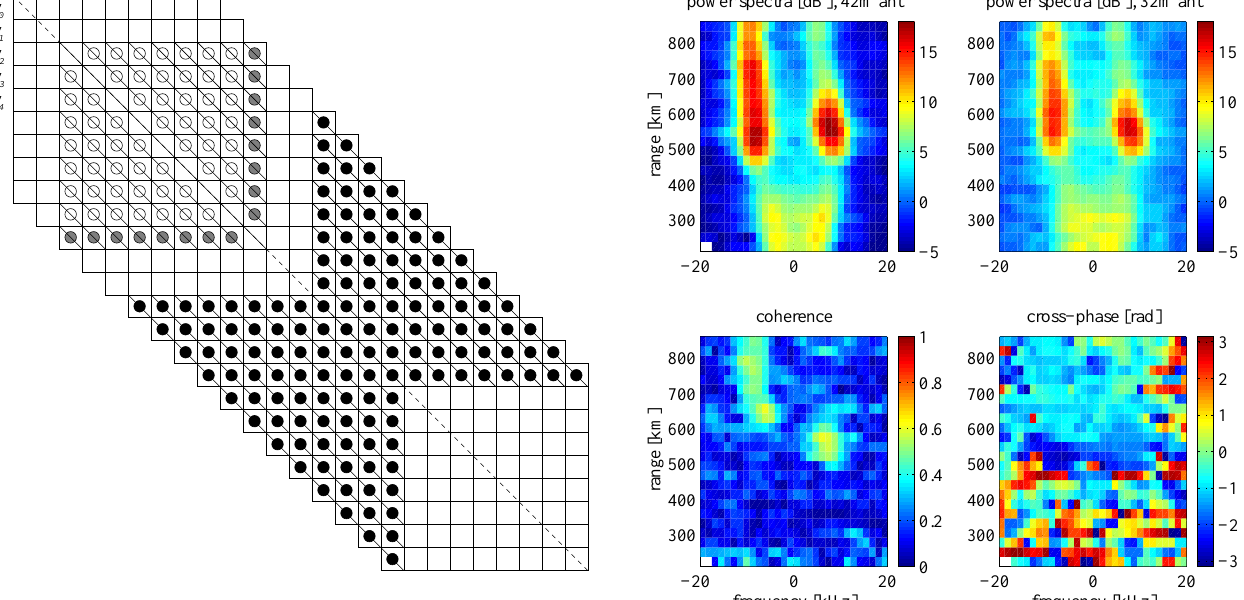
Fig. 12. A small cross-correlation lag profile matrix (XLPM), il- lustrating the shape of a range gate for coded and uncoded modula- tions, where points considered together (a single lag) are connected with diagonal lines. For alternating codes, the open and shaded circles constitute a range gate. In the decoded XLPM, the shaded circle indicates the position of the points resulting from this range gate. For fractional alternating codes, the picture will be slightly more complicated in the decoded XLPM, as each non-integer lag can be decoded in two ways. The black circles indicate a range gate for a long pulse XCF estimation, where the trapezoidal summation rule commonly used for long pulse ACF estimation is extended to negative lags. This part of the figure corresponds to Fig. 3 by Gry- deland et al. (2004). In this case, four points are added for the zero lag, five for the first lag, etc. Seventeen lags are computed in total: eight positive, eight negative and the zero lag.